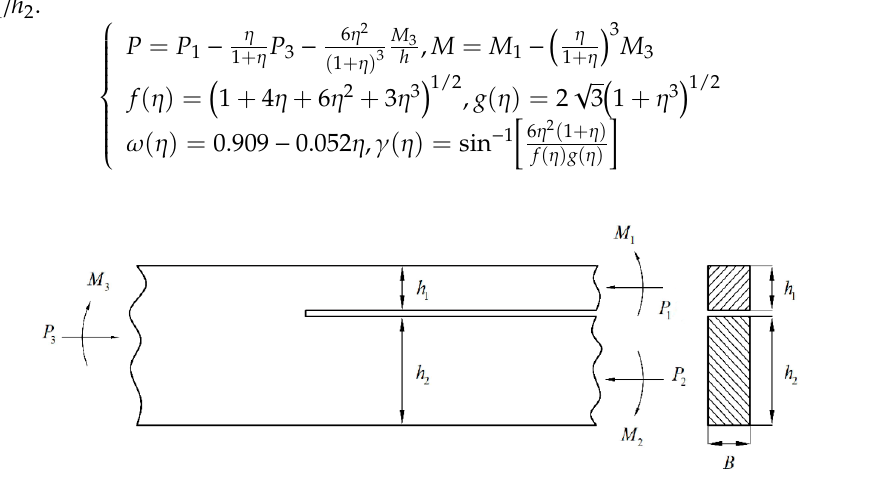
Figure 15. Analysis of the SIF of preset crack tip with external forces and bending moments.